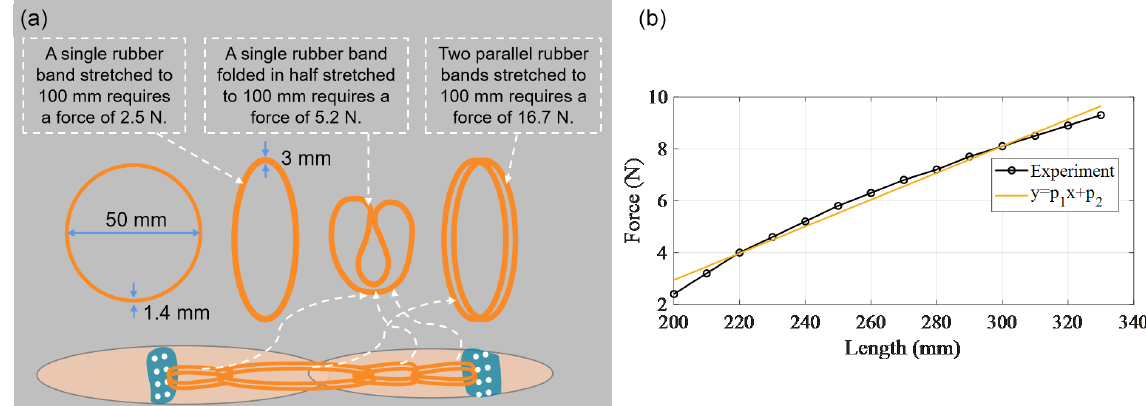
Figure 4. The design of the bionic antagonistic muscles of the elbow joint. (a) The design of the bionic antagonistic muscle. (b) The tensile test results.